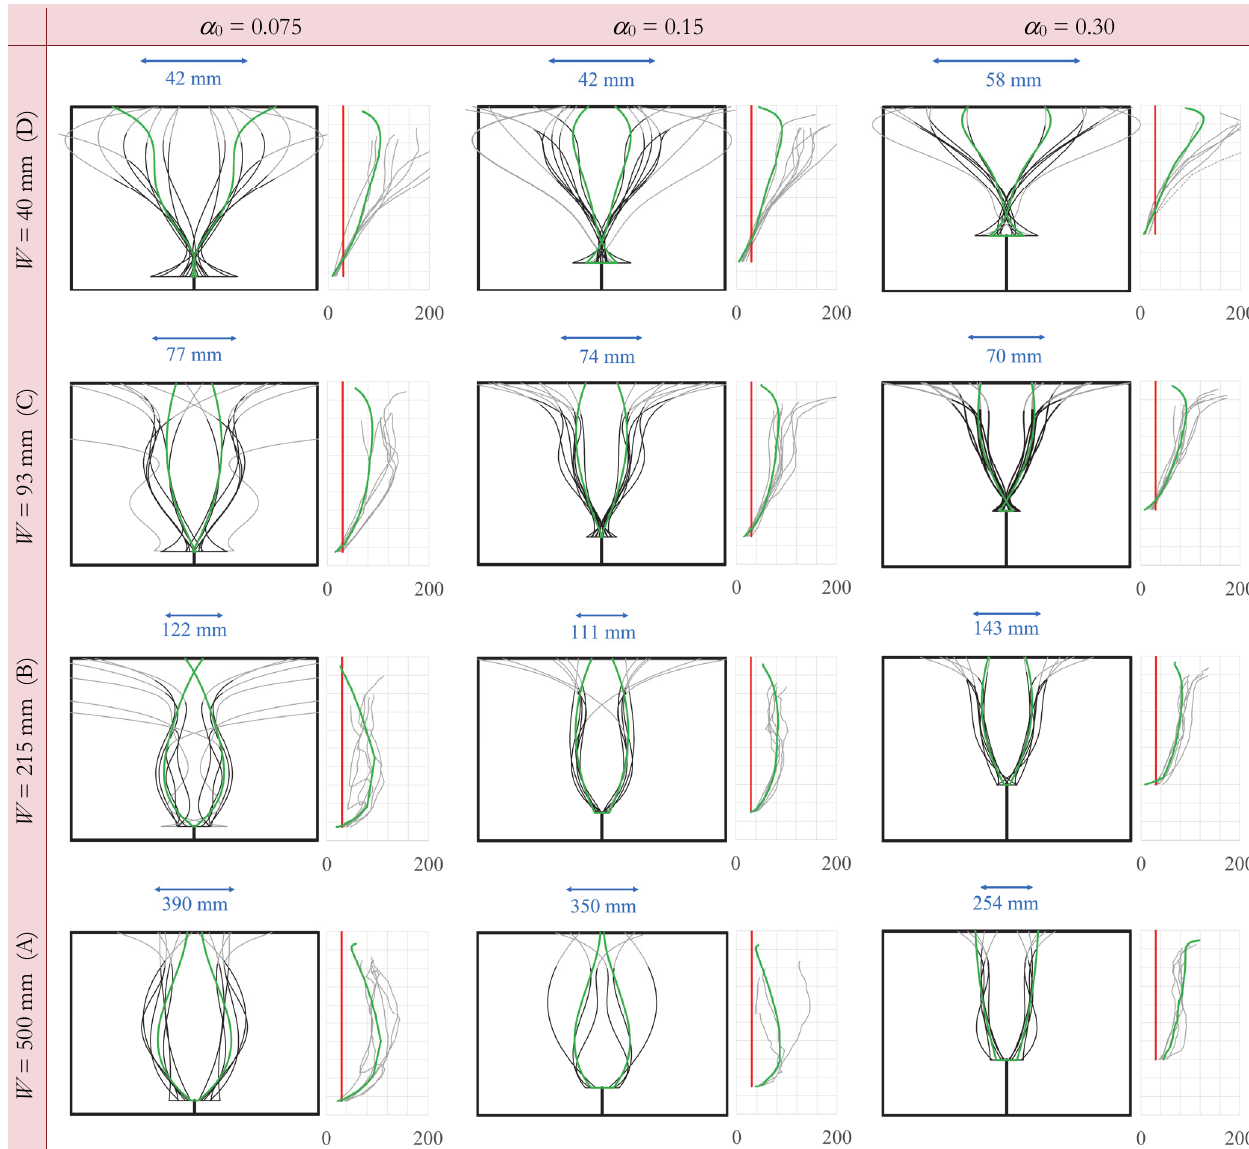
Figure 5: Scheme of the notched beam (the width W is scaled by a factor of 1.34 with respect to the length L ; in reality L/W = 2.4) with the indication of the envelope of the FPZ for each tested sample and the FEM simulated response (green line); each figure is complemented with R -curve plots (grey lines, the red line corresponds to the G f value released for the effective crack